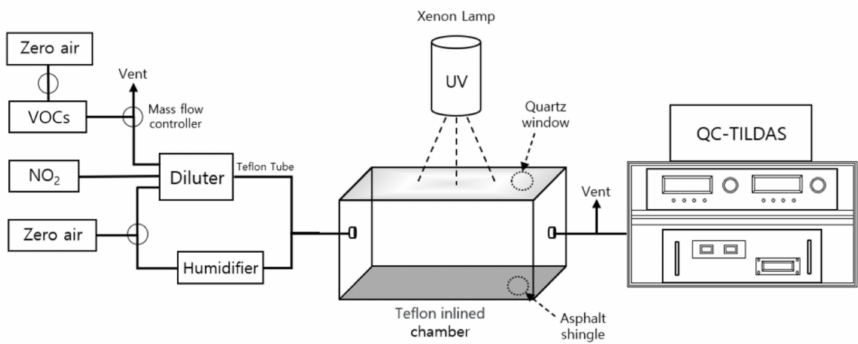
Figure 1. Schematic diagram of continuous flow reaction chamber